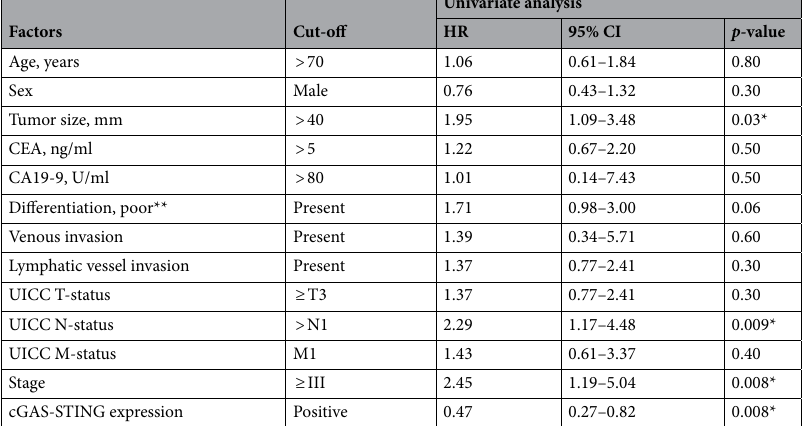
Table 2. Clinicopathological characteristics associated with overall survival outcomes in PDAC patients- Univariate Cox proportional hazard models. UICC, Union for International Cancer Control; HR, Hazard Ratio; 95% CI, 95% Confidence Interval; *Indicates statistical significance, < 0.05; **Indicates the cases which contain poorly differentiated component in the